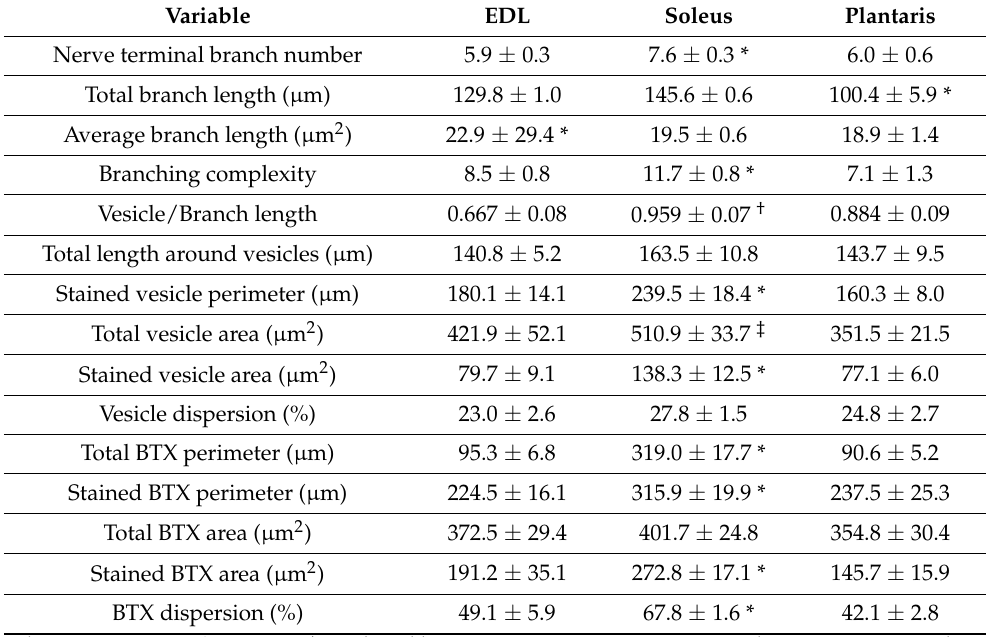
Table 1. Cellular morphology of NMJs in muscles of